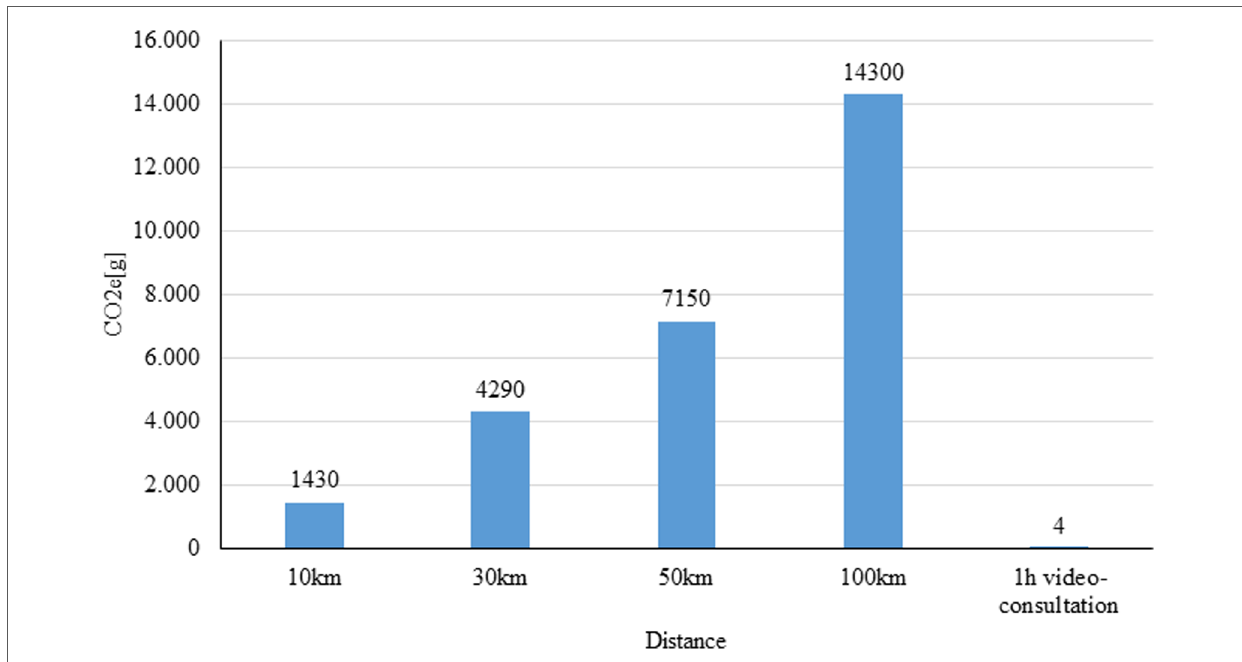
FIGURE 5 Calculated greenhouse gas emissions if patients would have travelled by